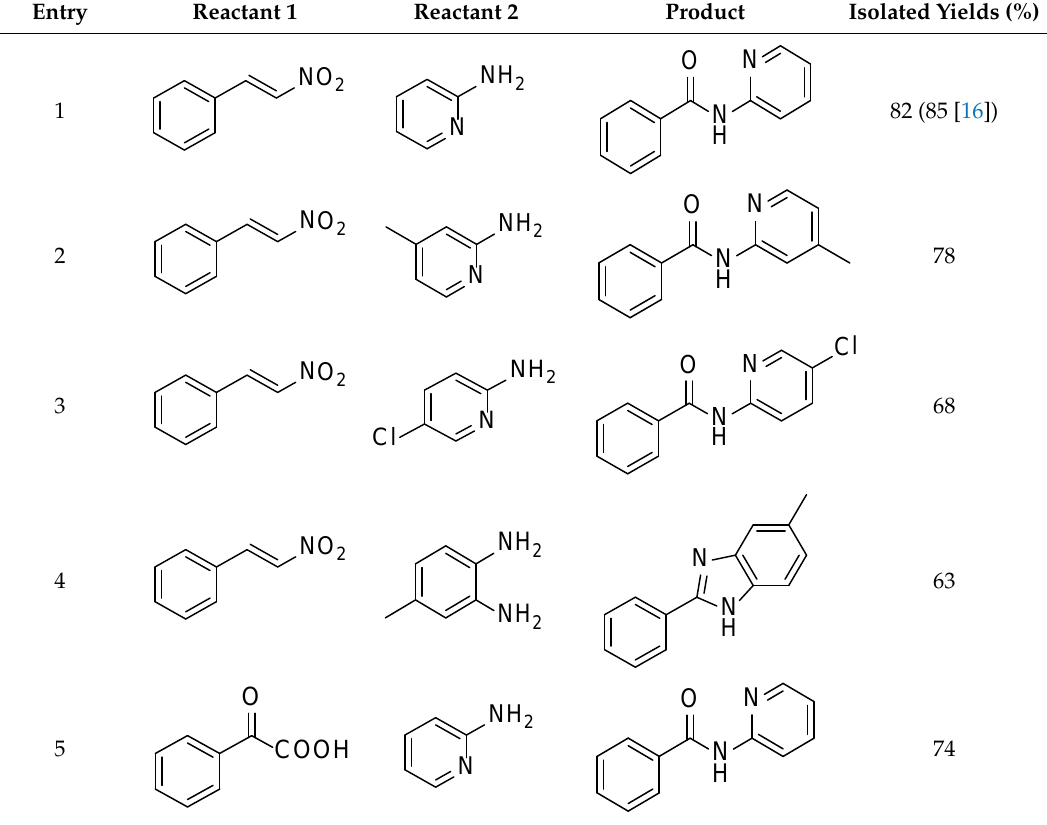
Table 1. Synthesis of di ff erent N-(pyridin-2-yl)-benzamide derivatives utilizing Fe 2 Ni-BDC catalyst.